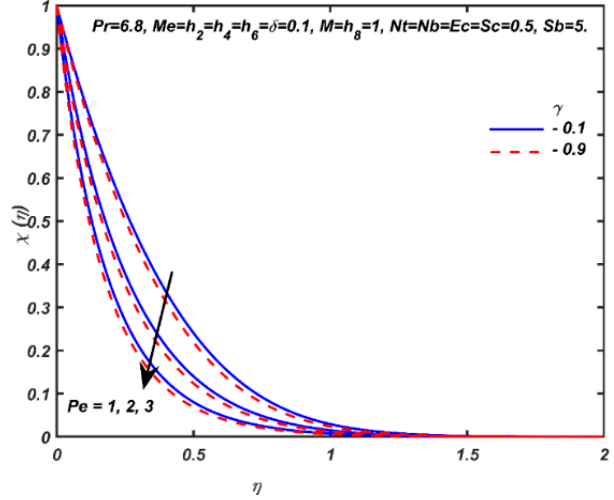
γ Figure 8. Effects and Pe on the dimensionless micro-organism density number function. Figure 8. E ff ects γ and Pe on the dimensionless micro-organism density number